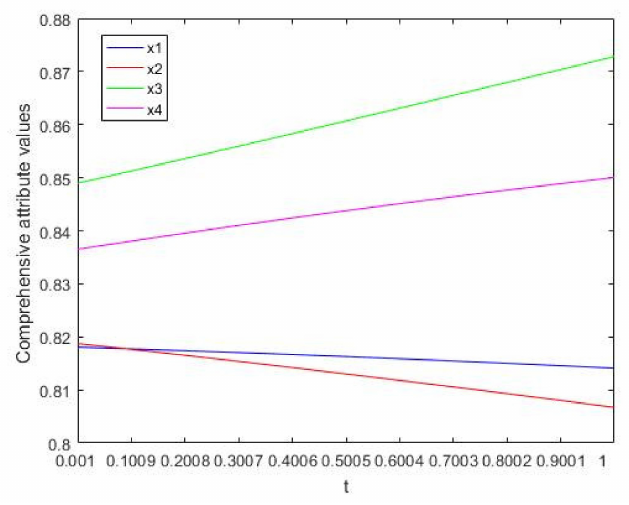
Figure 1. s = 1, t ∈ [ 0.001, 1 ] .